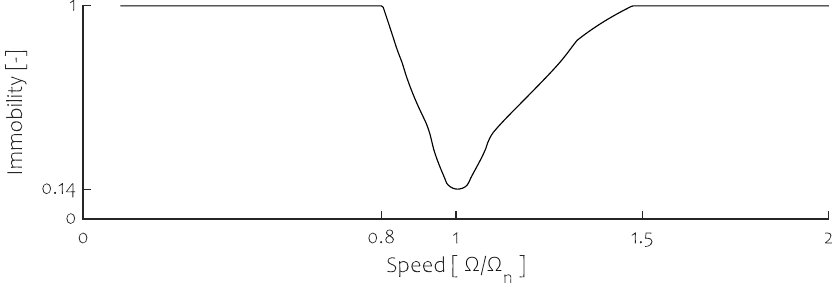
Figure 8. Immobility in function of rotational speed for an initial unbalance of G